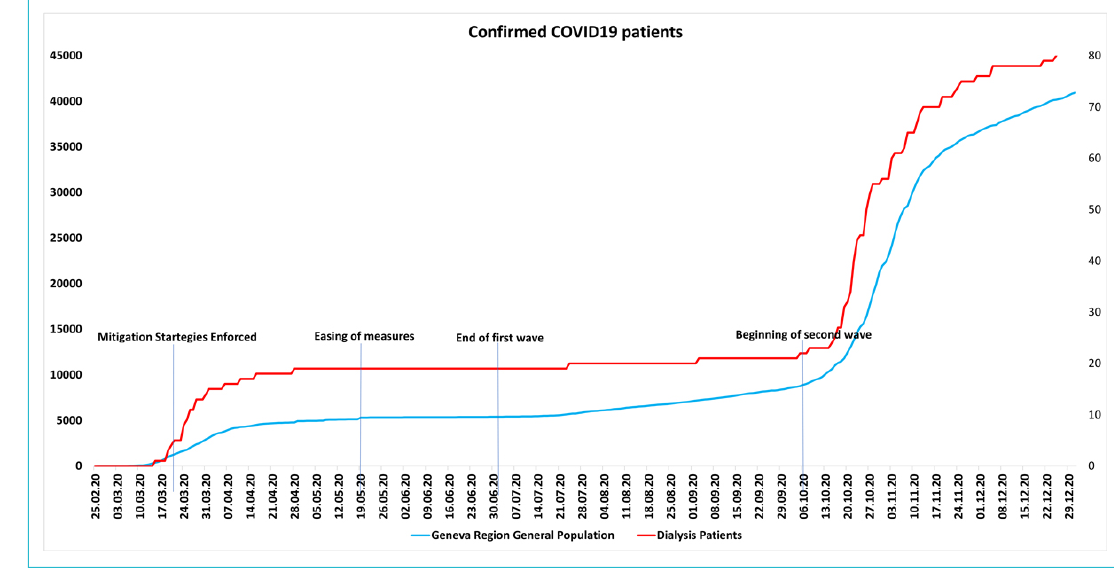
Figure 2: Cumulative frequency of SARS CoV-2 in the general population and in patients on maintenance